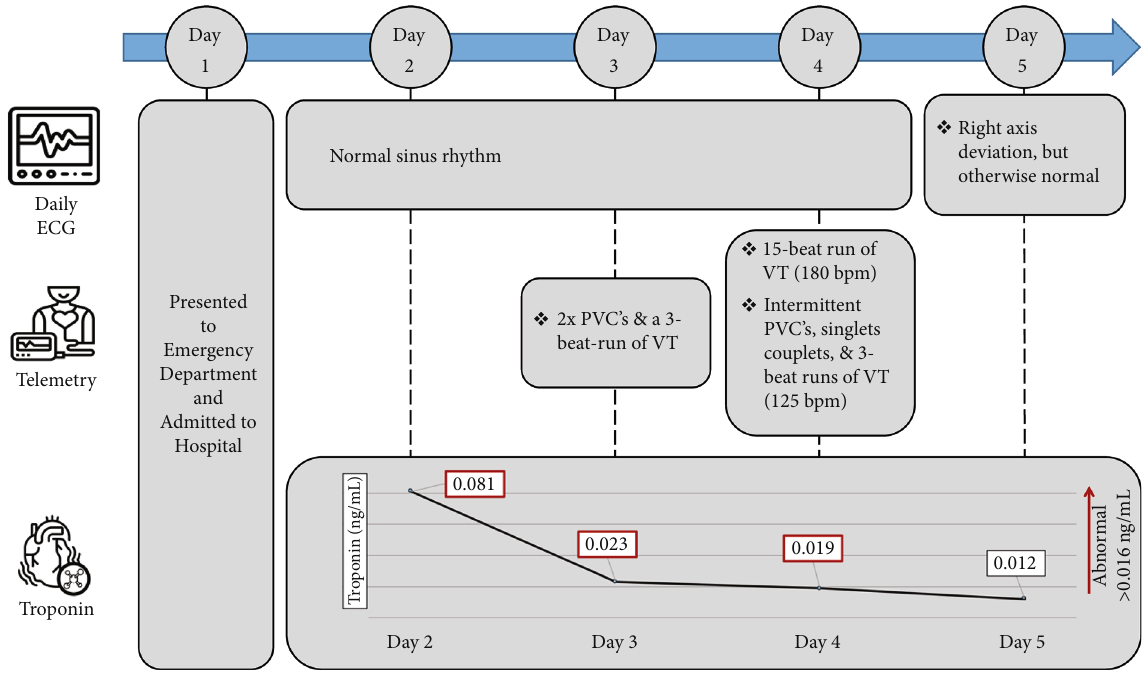
Figure 1: Cardiac monitoring and troponin inpatient cardiac monitoring, with time measured from the patient ’ s initial hospital presentation. PVC =premature ventricular contraction; VT =ventricular